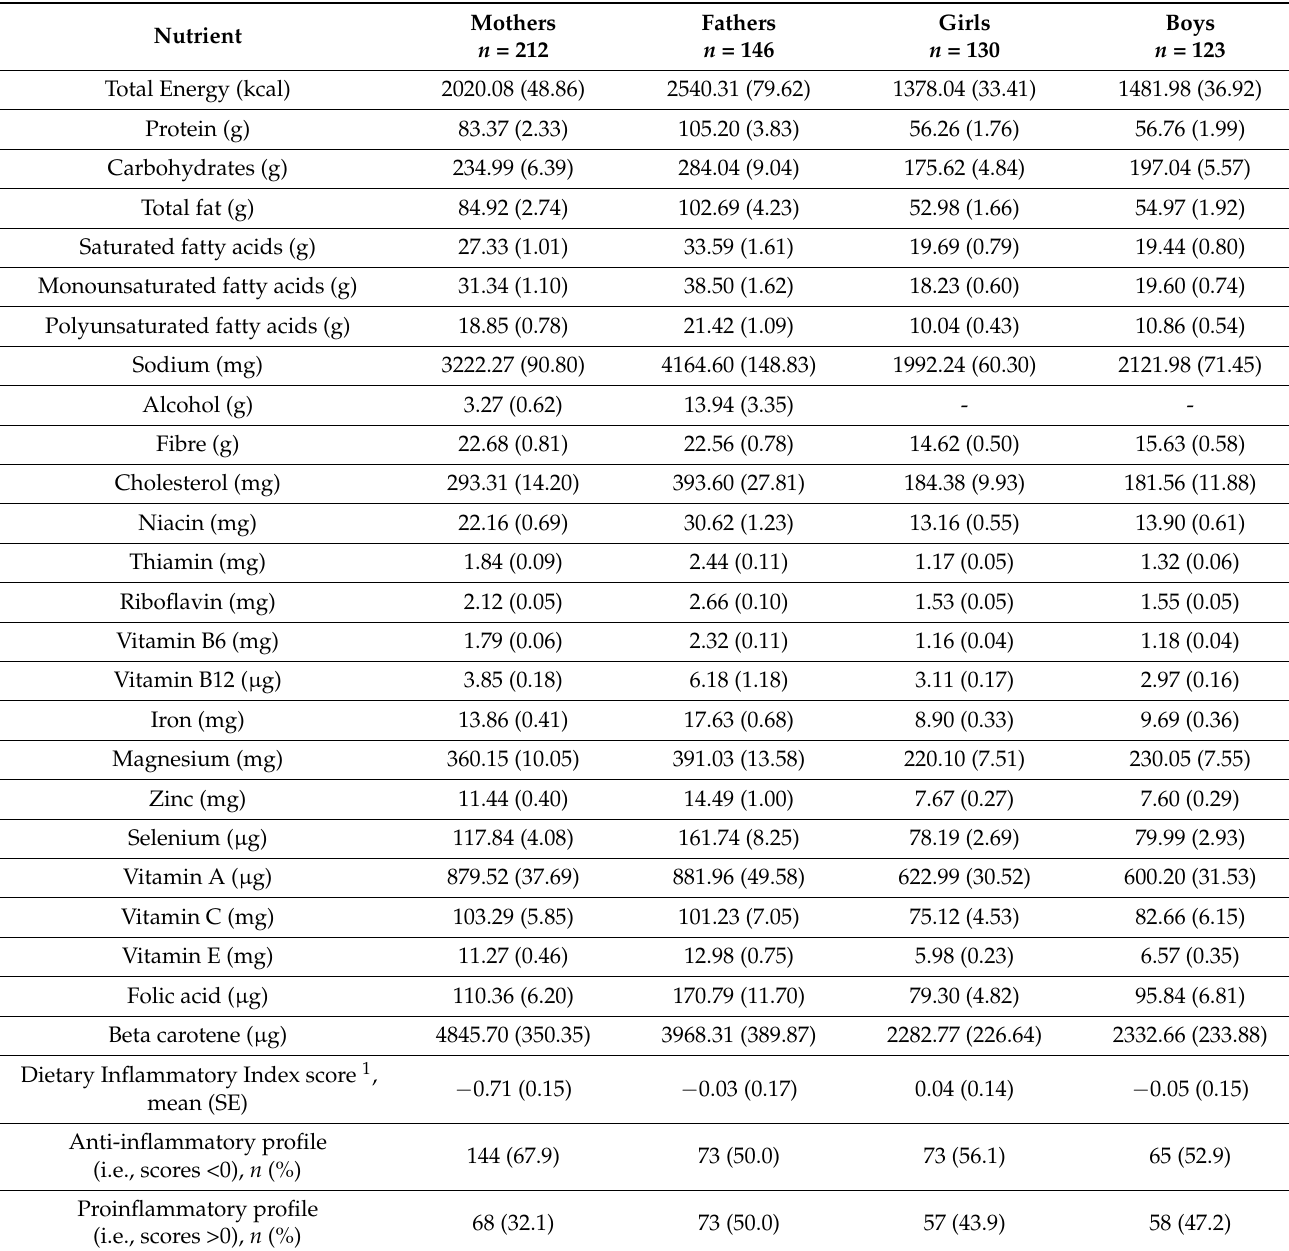
Table 2. Summary of nutrient intakes used in E-DII and C-DII calculations and mean scores 1 , stratified by sex. Intake assessed using the ASA24 self-reported online dietary recall